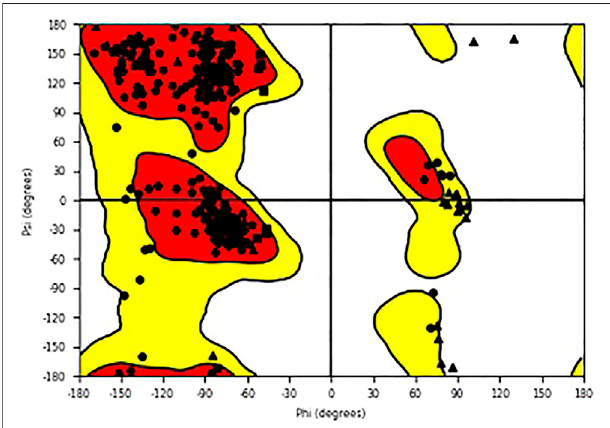
FIGURE1| 6LU7optimizedproteinstructureusingRamachandranplot.